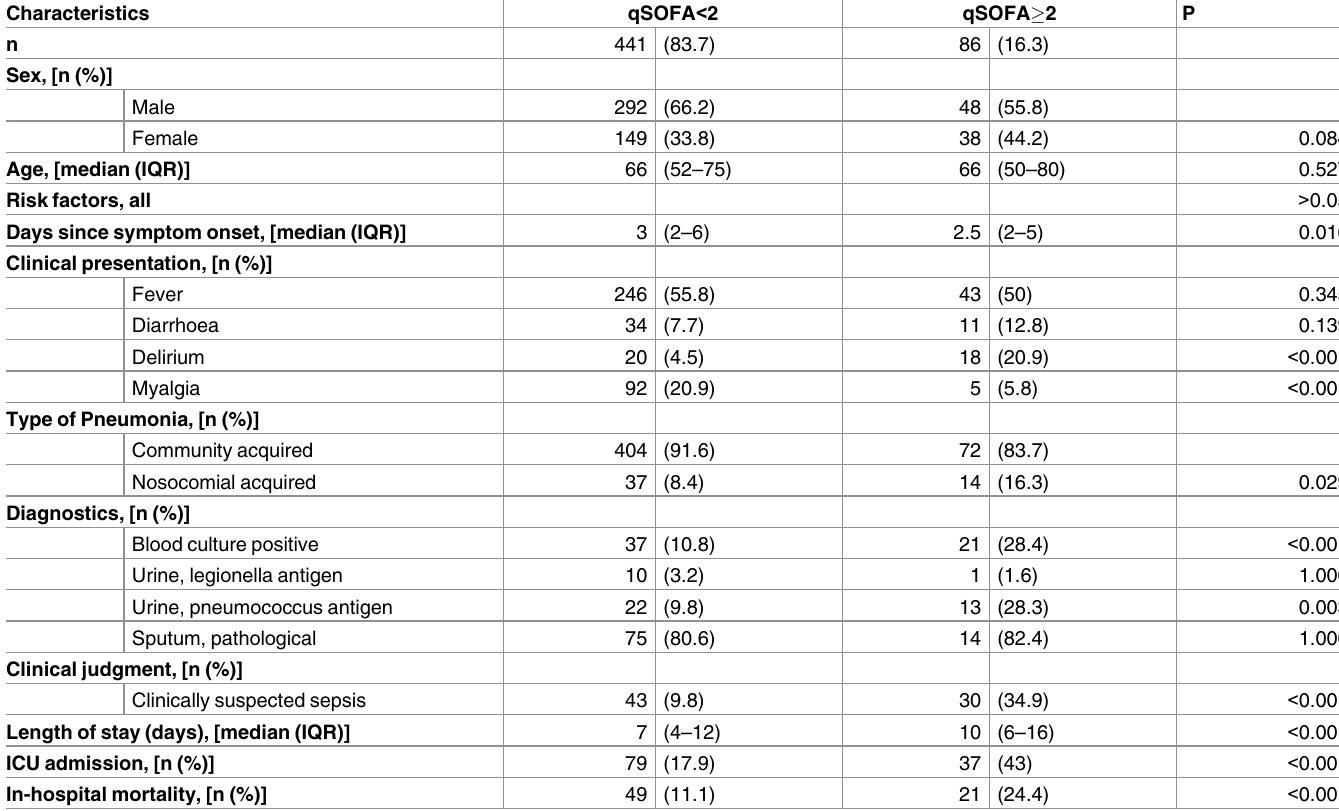
Table 2. Comparison of qSOFA-positive and qSOFA-negative patients.